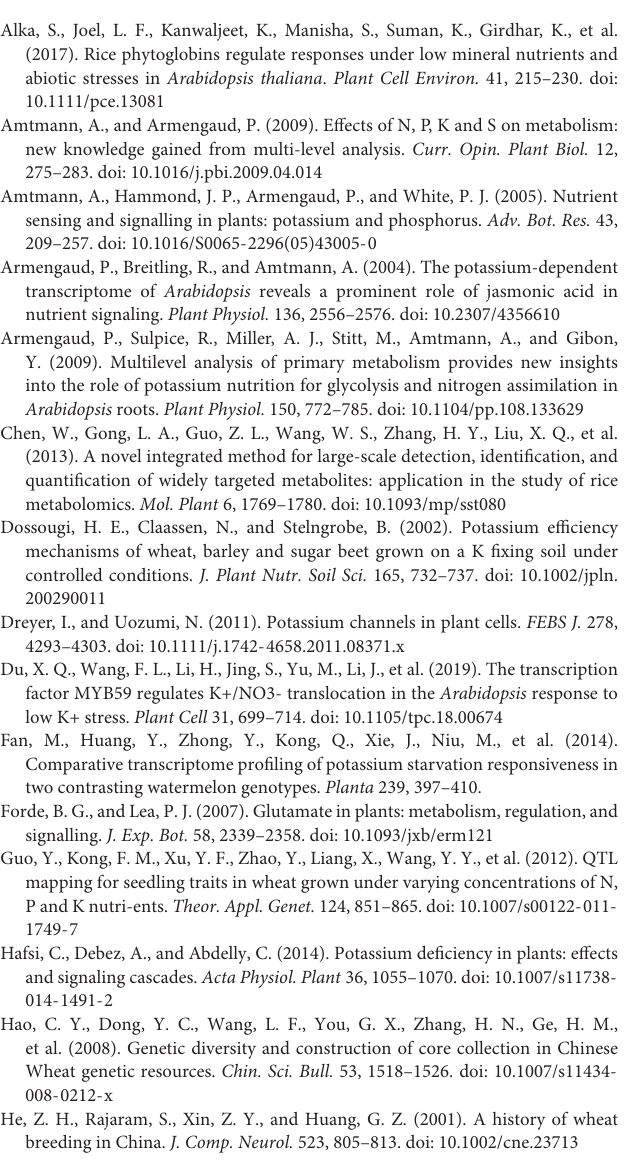
Supplementary Table 4 | D value rankings for 543 genotypes at the seedling stage. Supplementary Table 5 | D value rankings for 543 genotypes at the mature stage. Supplementary Table 6 | Summary of sequencing data quality. TCK, KN9204 after the control K treatment; TLK, KN9204 after the low-K treatment; SCK, BN207 after the control K treatment; SLK, BN207 after the low-K treatment. Supplementary Table 7 | Genes encoding transporters and CIPKs that were differentially expressed between genotypes under low-K stress conditions. “–” indicates no significant difference in gene expression. Supplementary Table 8 | Genes encoding peroxidases that were differentially expressed between genotypes under low-K stress conditions. “–” indicates no significant difference in gene expression.